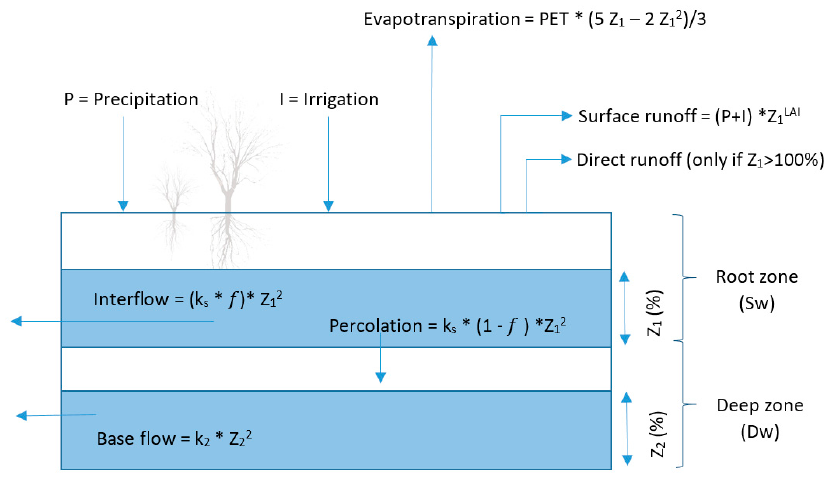
Figure 2. Diagram of the soil moisture method, adapted from